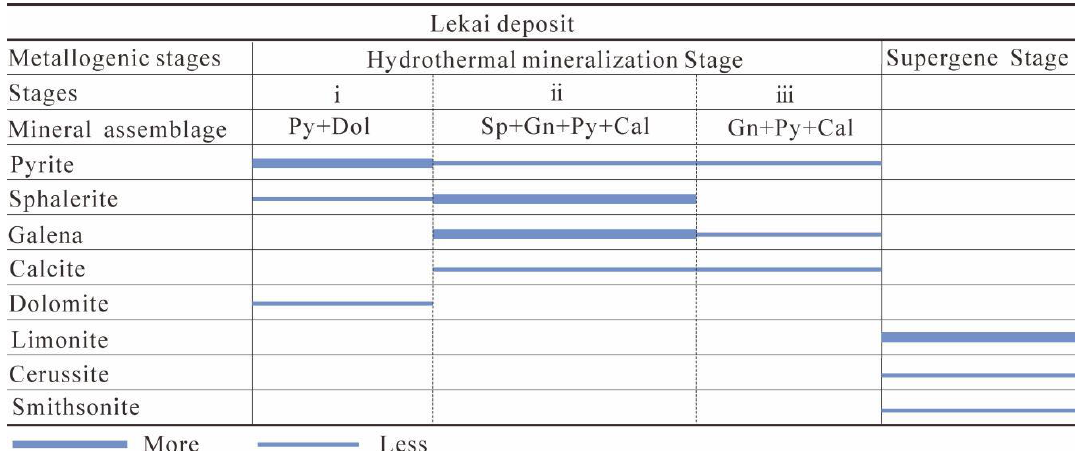
Figure 6. Mineral paragenesis of the Lekai Pb-Zn deposit [30].